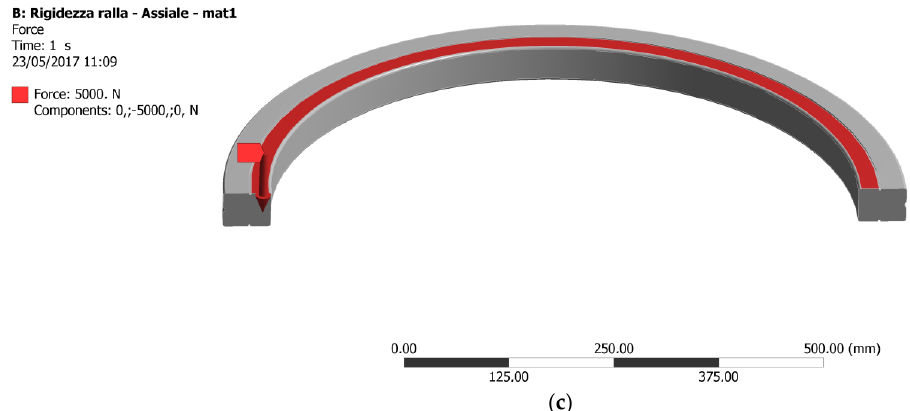
Figure 9. ( a ) Symmetry region, ( b ) fixed support, ( c ) load application surface.